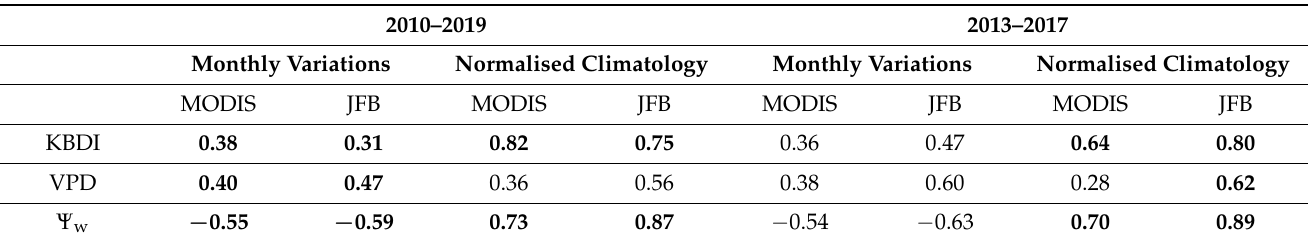
Table 3. Correlation between monthly variations and normalised climatologies of KBDI, VPD, Ψ w and fire occurrence derived from MODIS and JFB for south-central Jamaica. For 2010–2019, KBDI, VPD and Ψ w are derived using ERA5, while for 2013–2017 they are derived using station data. Correlations in bold are statistically significant at the 95% confidence